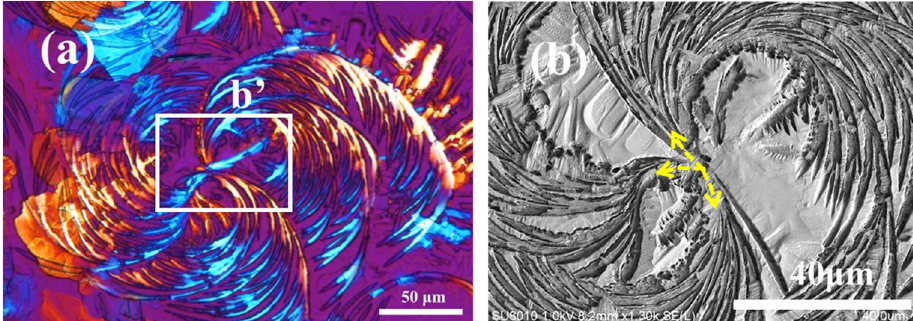
Figure 9. ( a ) POM, b’ indicating the white-squared region to be zoomed-in by SEM and ( b ) SEM micrograph of (R)-MA/PVPh (50/50) blend crystallized at T c = 65 °C.